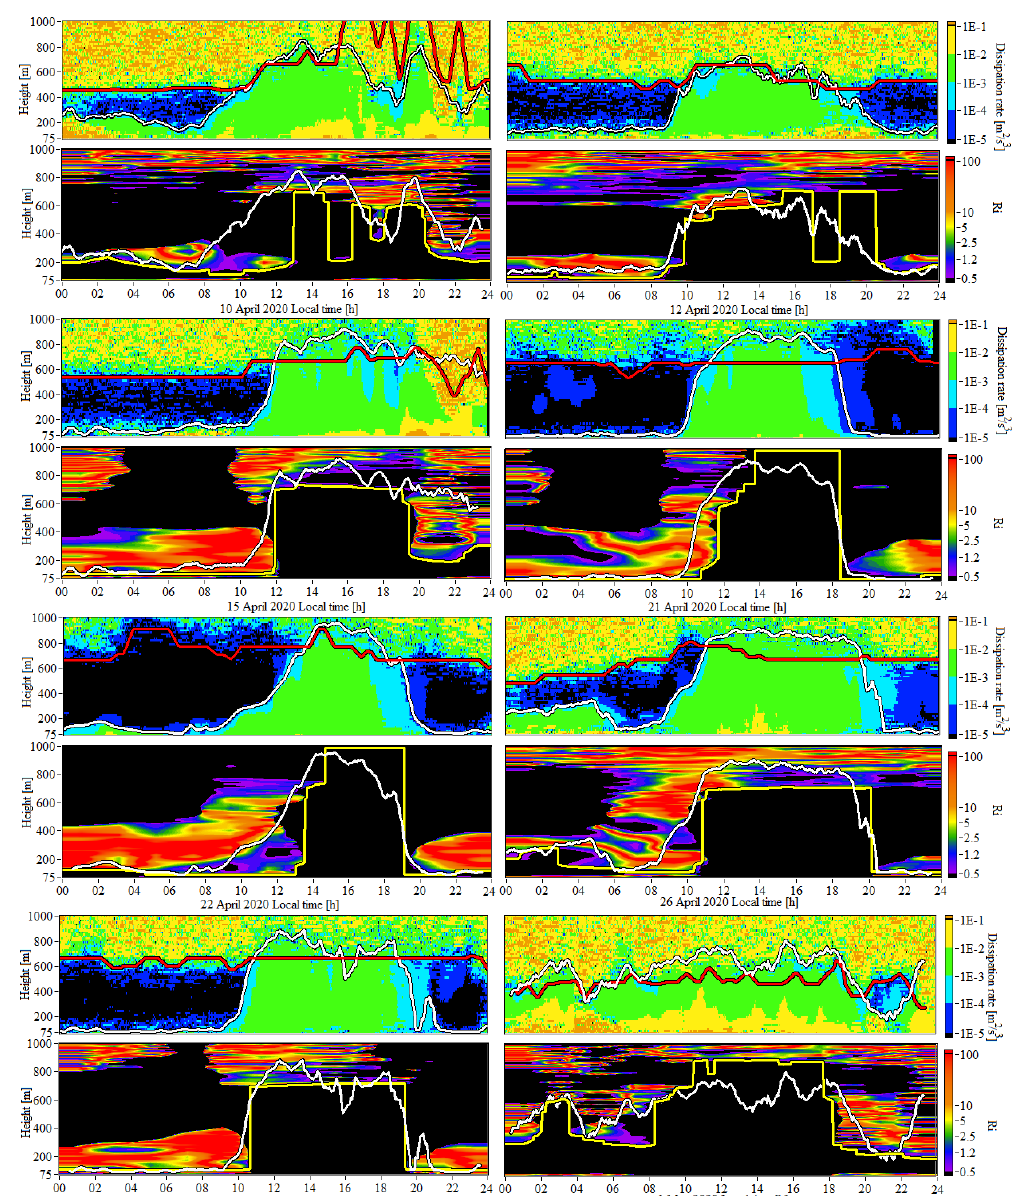
Figure 11. Height–temporal distributions of the turbulence energy dissipation rate and the Richardson number as obtained from measure- ments on 10, 12, 15, 21, 22, 26, and 27 April and on 1 May 2020. White curves reproduce the diurnal time series of the turbulent mixing layer height, as estimated from the turbulence energy dissipation rate. Red curves show the diurnal time series of the SNR at the level − 16dB. Black color on the Richardson number distributions shows the zones where Ri < 0 . 5. Yellow curves show the diurnal time series of the turbulent mixing layer height, estimated as a minimum height, above which the Richardson number exceeds